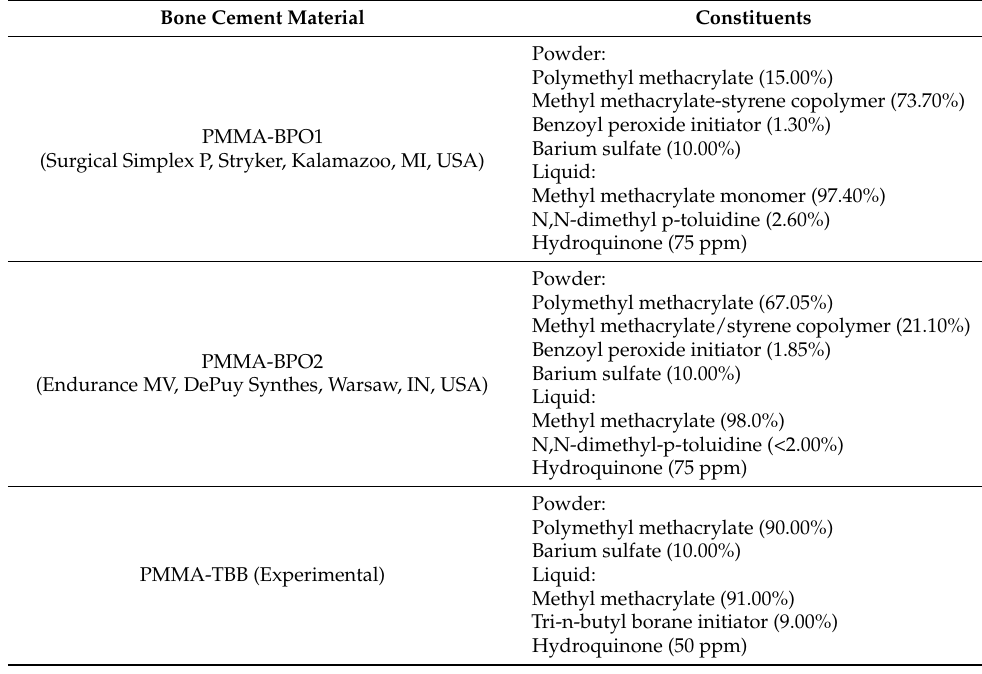
Table 1. The constituents of three different bone cement materials were used in this study. Bone Cement